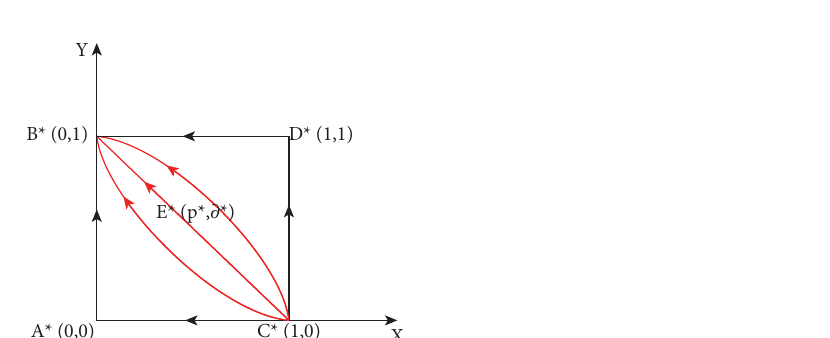
Numerical Symbols